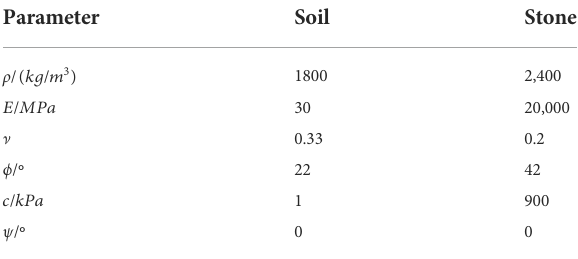
TABLE 1 Material parameters for the SRM slope. Parameter Soil